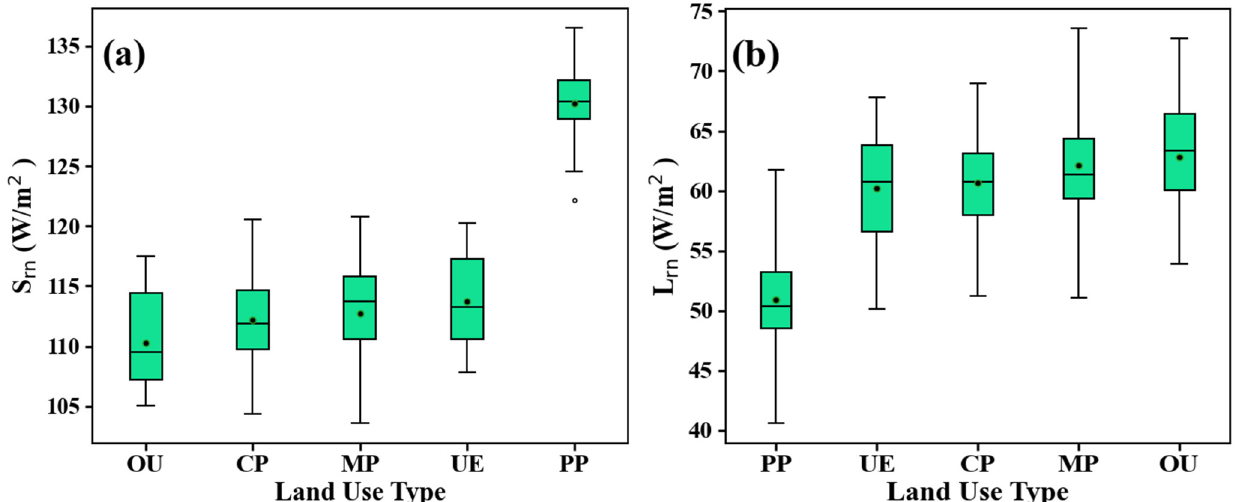
Figure 5. Statistical values of ( a ) net short-wave radiation ( S (cid:2928)(cid:2924) ) and ( b ) net long-wave radiation ( L (cid:2928)(cid:2924) ) based on five land types in the Yangtze River basin from 2000 to 2020. based on five land types in the Yangtze River basin from 2000 to